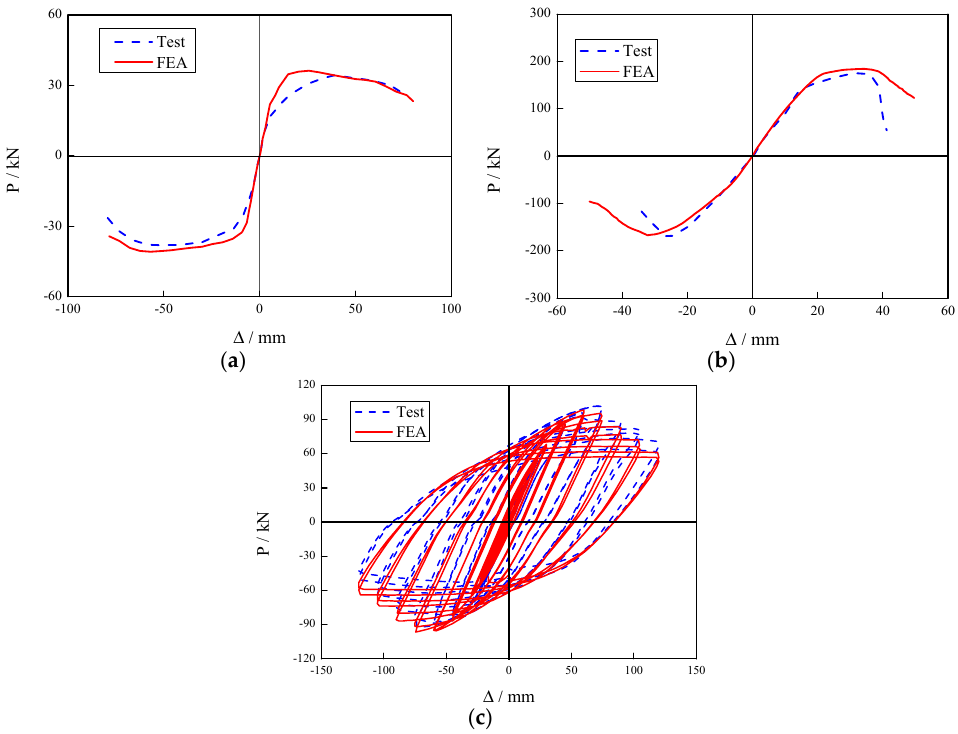
Figure 5. Comparison between the test results and finite element analyses (FEA) predictions (P: Load applied to the beam end, ∆ : displacement at the beam end). ( a ) SJ-32; ( b ) CFRTJ-3; ( c ) CJ-22.